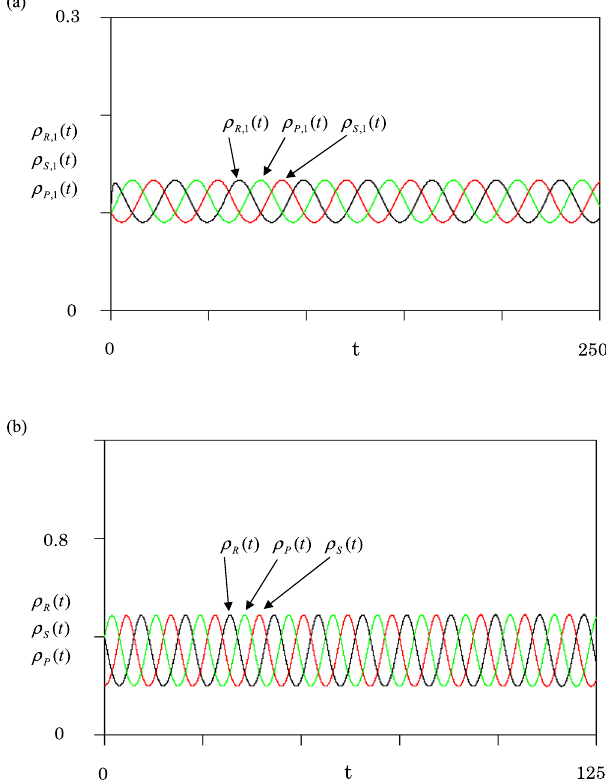
Figure 2. Results of population dynamics at rate = = = a b c 1 . ( a ) Metapopulation model for homogeneous graph in Fig. 1(a). The densities of three species (R, S, P) in node 1 are plotted against time t . The initial values are ρ = . for species α in node i ( α = R, S, P and = i 1, 2, 3 ), but the rock density in node 3 is only set as (0) 0 1 α i ρ = . (0) 0 2 . Black, red and green curves indicate the densities of rock, scissors, and paper in node 1, R ,3 respectively. ( b ) A single habitat case without migration. By the use of equation (2), the mean-field dynamics are displayed with initial values ρ ρ = = . (0) (0) 0 4 and ρ = . (0) 0 2 R P S